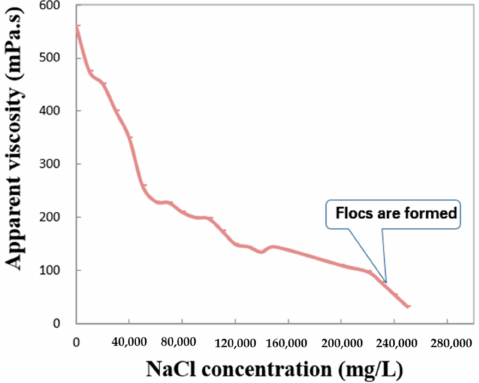
Figure 9. NaCl concentration versus apparent viscosity.